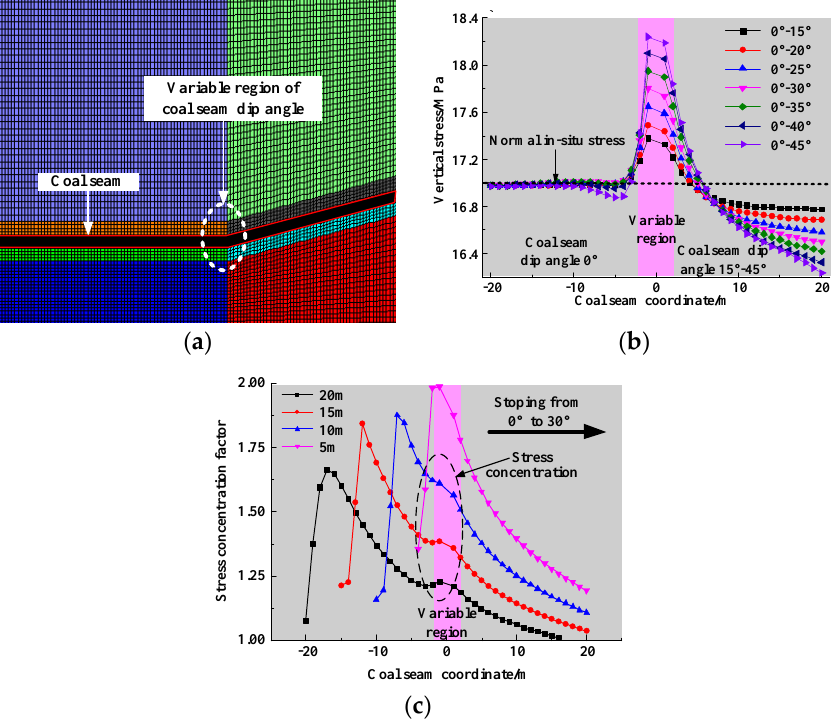
Figure 10. Numerical model of the variation of coal seam dip angle, in-situ stress distribution, and abutment pressure distribution, ( a ) numerical model of the variation of coal seam dip angle, ( b ) in-situ stress distribution, ( c ) distribution of abutment pressure when stoping from a dip angle of 0 to 30 ◦ .